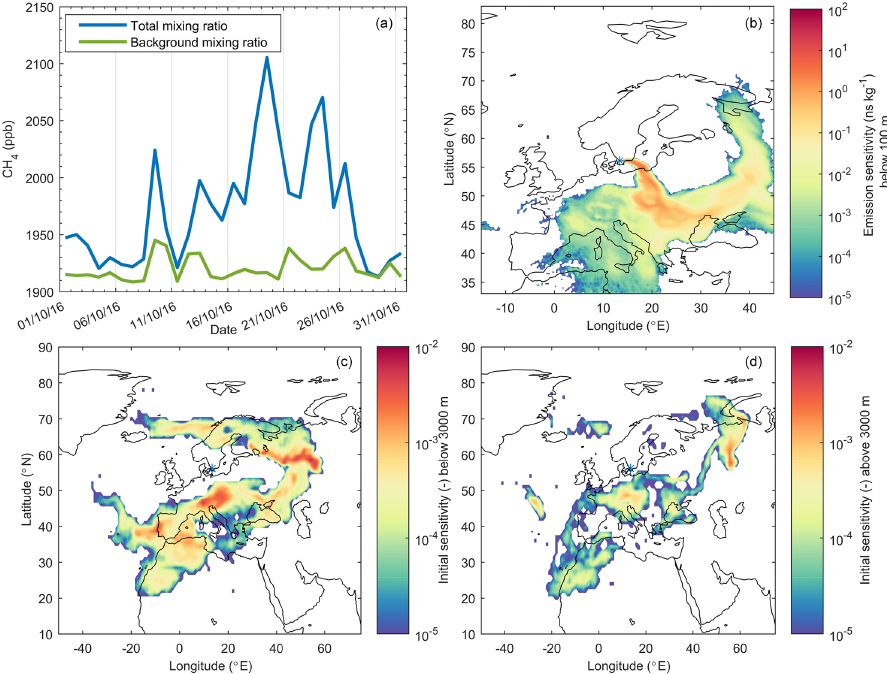
Figure 4. Example of FLEXPART 8d backward runs for methane from a site in southern Sweden (Hyltemossa) demonstrating the combined use of sensitivities to emissions and initial conditions. (a) Time series of methane background mixing ratios and total mixing ratios in Octo- ber 2016. (b) Sensitivity of the methane mixing ratio at Hyltemossa on 19 October 2016 to methane emissions at the surface. (c) Sensitivity of the methane mixing ratio at Hyltemossa on 19 October 2016 to methane initial conditions below 3000m. (d) Sensitivity of the methane mixing ratio at Hyltemossa on 19 October 2016 to methane initial conditions above 3000m. Blue asterisks on the maps mark the receptor